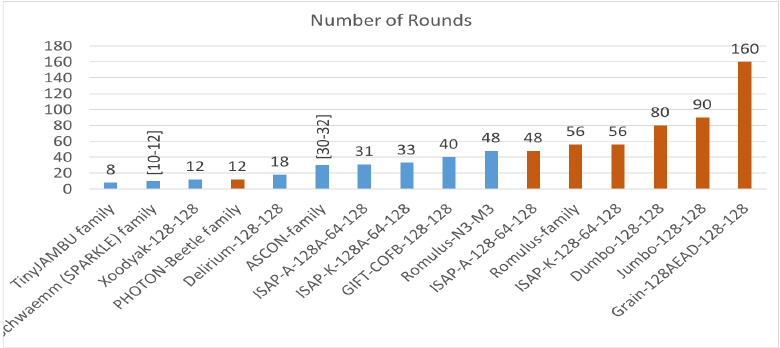
Figure 32. All algorithms of NIST finalists with their corresponding number of rounds. Brown color indicates the worst algorithms in previous